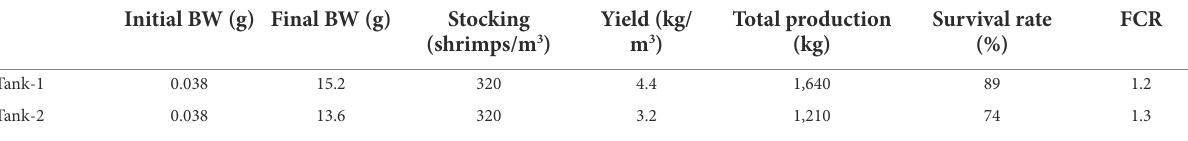
TABLE 1 Summary of Litopenaeus vannamei aquaculture reared in BFT system for 152